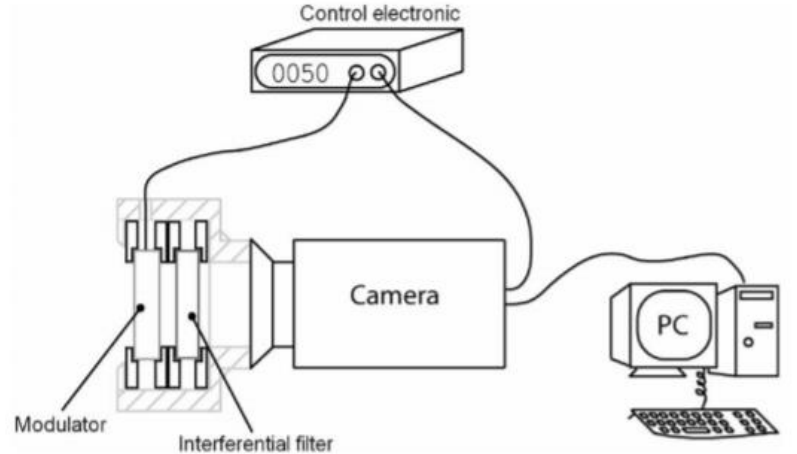
Figure 4. Schematic diagram of fixed variable delay wave plate [20].